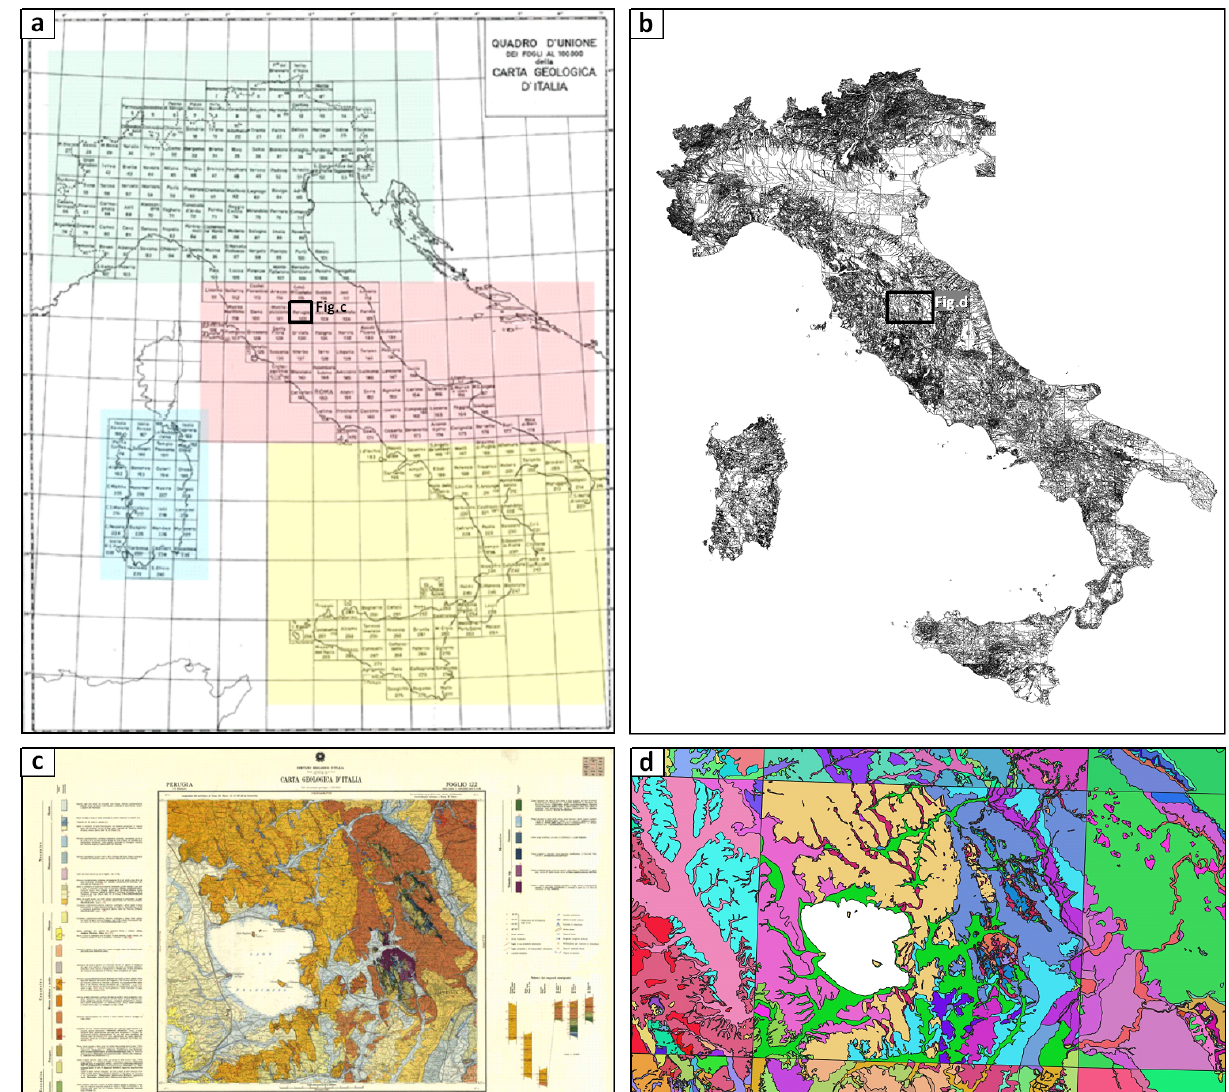
Figure 1. (a) The 277 sheets of the geological map of Italy at the 1 : 100000 scale as visualized on the ISPRA website (Table 1, ID 6). The location of (c) is indicated. (b) All 292705 unclassified vector polygons available in the source dataset. The location of (d) is indicated. (c) Published version of sheet no. 122 “Perugia” as visualized in raster form at the ISPRA website (Table 1, ID 6). (d) Randomly coloured polygons within the area encompassing sheet no. 122. Polygons with the same geological description in the original attribute table (field: NAME) provided by ISPRA (Table 1, ID 9) assume the same colour. The area also encompasses the straight boundaries with its surrounding four geological sheets, clearly visible as sharp colour changes along NS- and WE-oriented straight